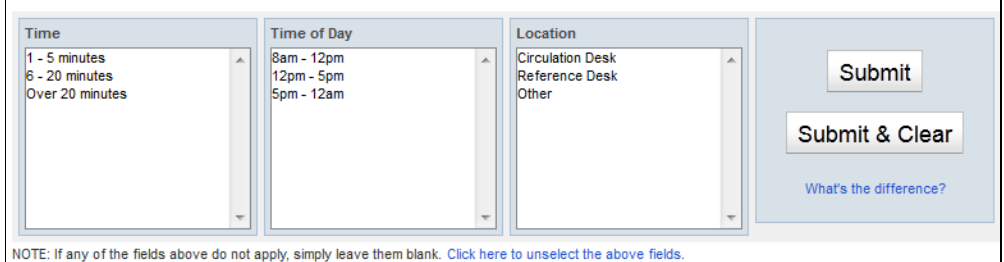
Data fields that are selected for each transaction entered into the